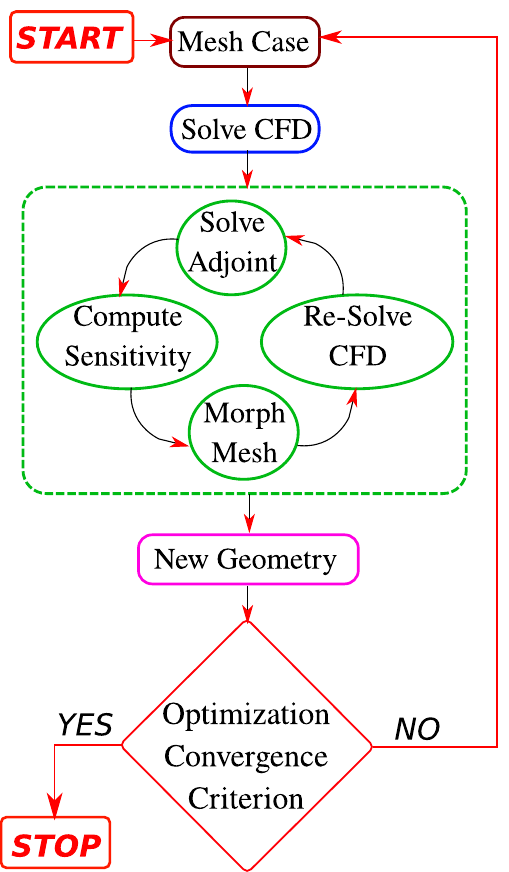
Figure 10. The Computational Algorithm of the Adjoint and CFD Solvers with Mesh Morphing technique. The optimization convergence criterion is based on a steepest descent gradient-based optimization